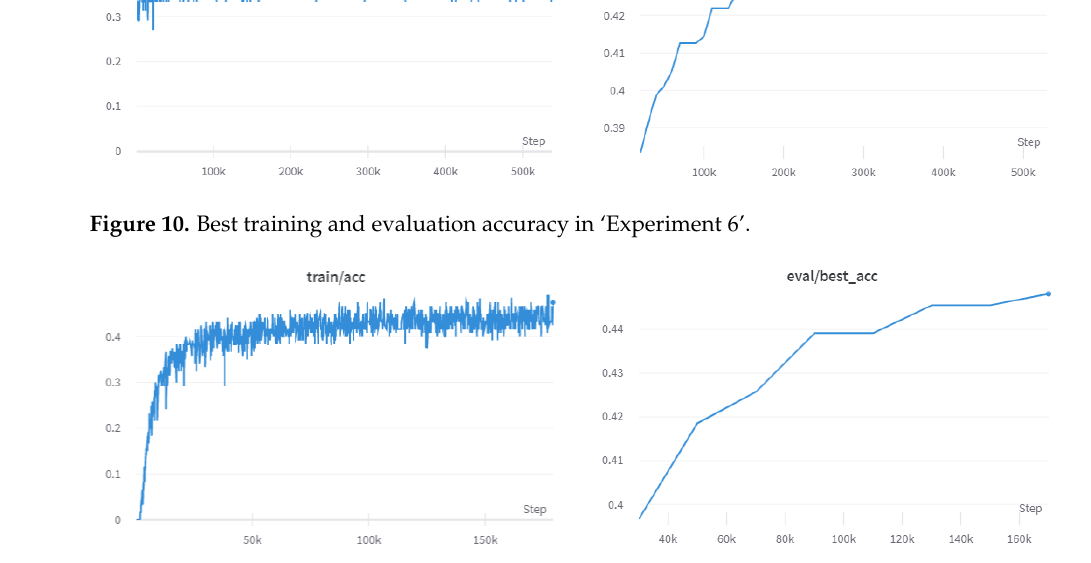
Figure 11. Best training and evaluation accuracy in ‘Experiment 7’.